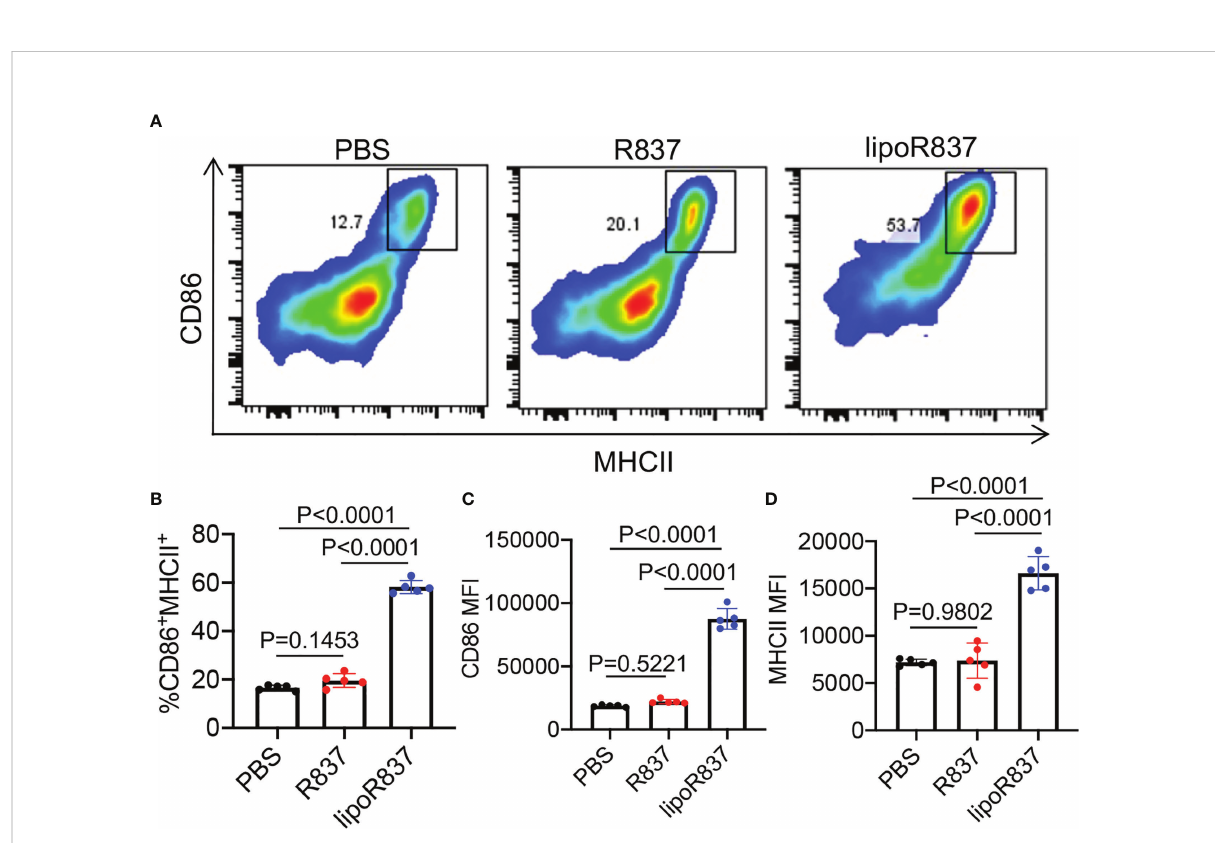
FIGURE 5 R837-loaded liposome outperforms R837 in improving the activation of DCs. BMDCs were incubated with free R837, R837-loaded liposomes (lipoR837), or PBS for 16 h, followed by FACS analysis of cell-surface CD86 and MHCII levels. (A) Representative CD86-MHCII plots of DCs after 16-h treatment with R837, lipoR837, or PBS. (B) Percentages of CD86 + MHCII + DCs following different treatments. Also shown are the mean (C) CD86 and (D) MHCII fl uorescence intensity of DCs after different treatments. All the numerical data are presented as mean ± SD.